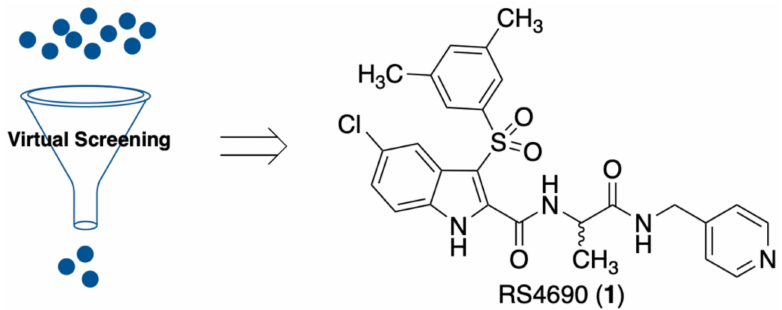
Figure 1. Compound RS4690 ( 1 ) achieved from virtual screening